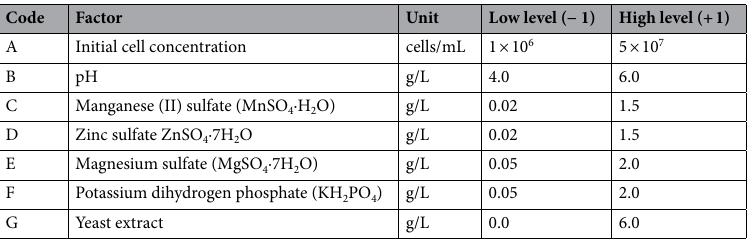
Table 1. Codes and actual values of the independent factors for the designed